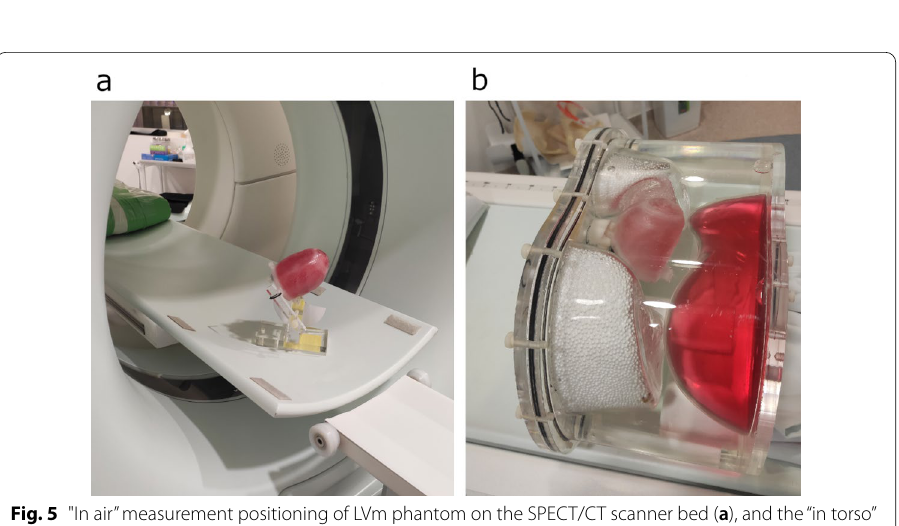
In the first experiments, LVm healthy and defective phantoms were measured without additional scattering media ("in air”). The LVm healthy insert was also placed into the Anthropomorphic Torso Phantom for a second acquisition (“in torso”)